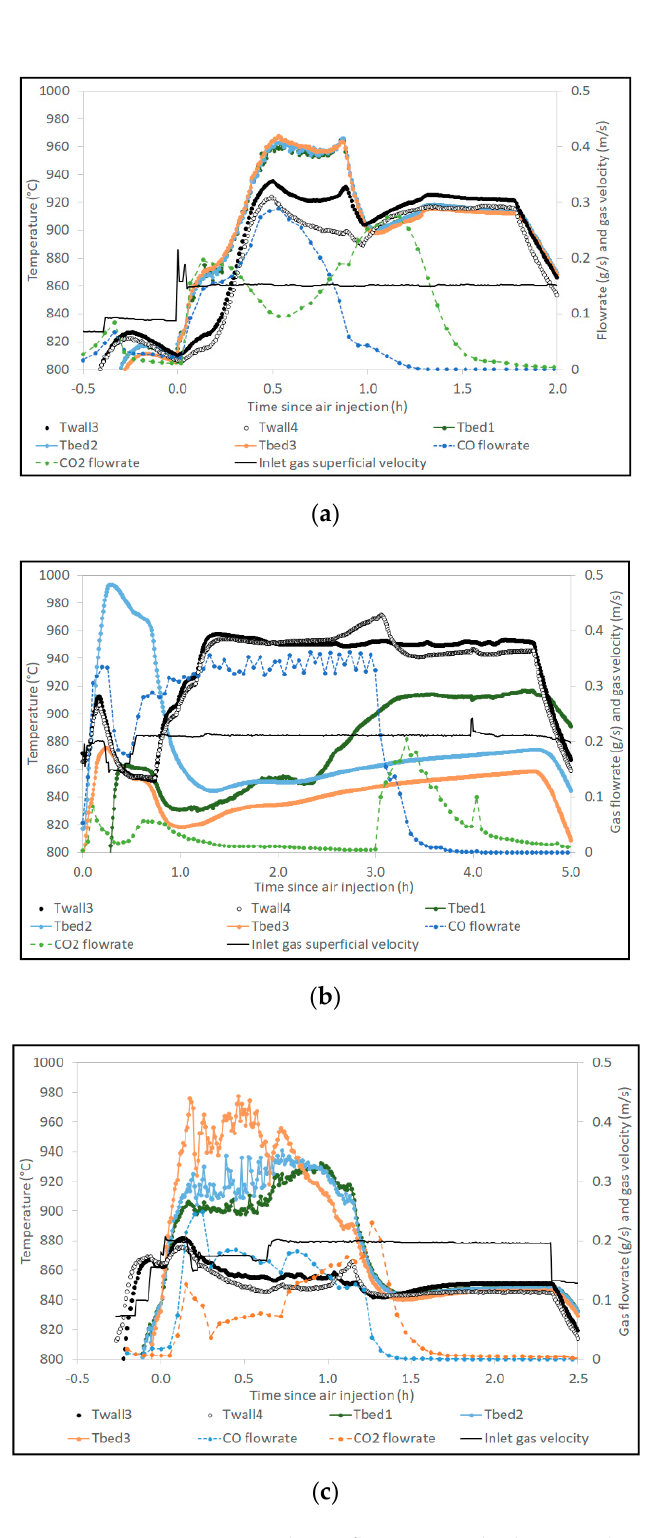
Figure 2. Temperature measurements, CO and CO 2 flowrates and inlet gas velocity in fluidised bed combustion experiments for ( a ) bark, ( b ) lignin residue, ( c ) 50/50 wt% bark-wheat straw blend. At the outlet, we considered: